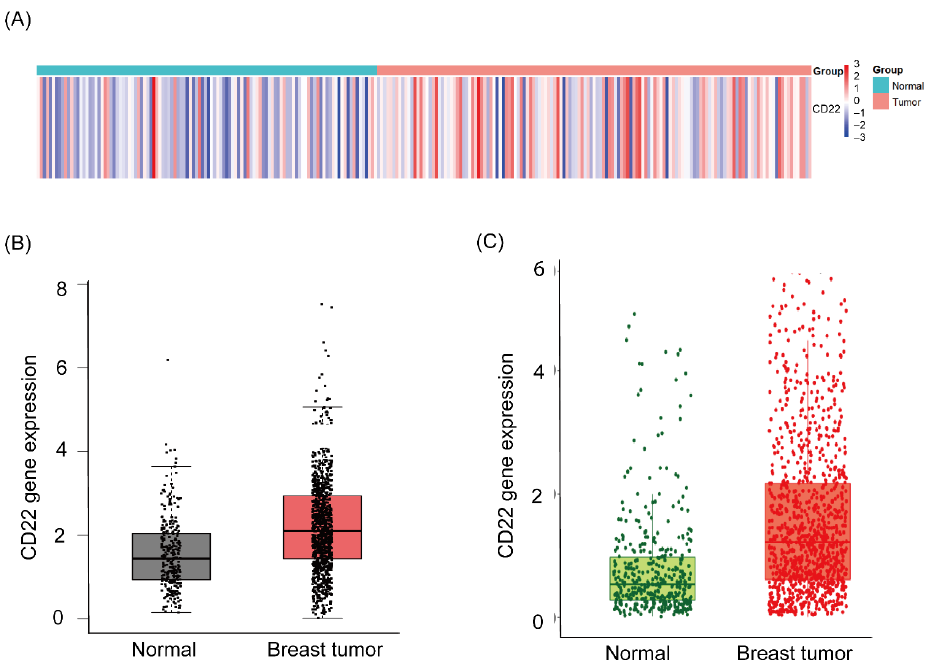
Figure 1. Bioinformatics analysis of CD22 expression in breast cancer and normal tissues. ( A ) Heatmap of the expression values for CD22 from RNA-seq data in TCGA. ( B ) BOX plot for CD22 expression from GEPIA shows that CD22 is relatively highly expressed in Breast tumor as compared to normal tissues. ( C ) TNMplot for CD22 expression also shows high expression of CD22 in breast tumor as compared to normal tissues.